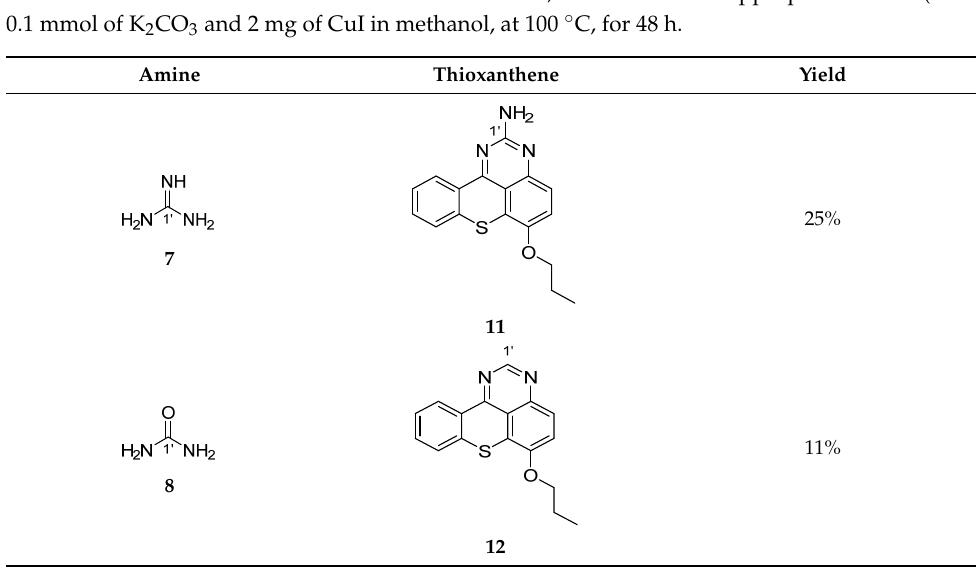
Table 1. Amines used ( 7 – 10 ) and tetracyclic thioxanthenes ( 11 – 14 ) obtained and their isolated yields. All the reactions were carried out with 0.1 mmol of 6 , 0.2 mmol of the appropriate amine ( 7 – 10 ),